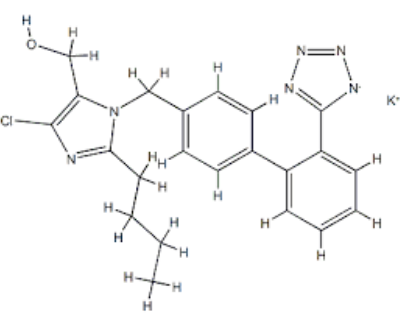
Figure 16. Chemical structure of EPO. Formula: C 815 H 1317 N 233 O 241 S 5. Physiological effect: Stimulation of erythroid progenitors [23]. It stimulates the pro- duction of red blood cells in the bone marrow and regulates the concentration of red blood cells and hemoglobin in the blood. Red blood cells carry oxygen to cells, including muscle cells, enabling them to function more efficiently.